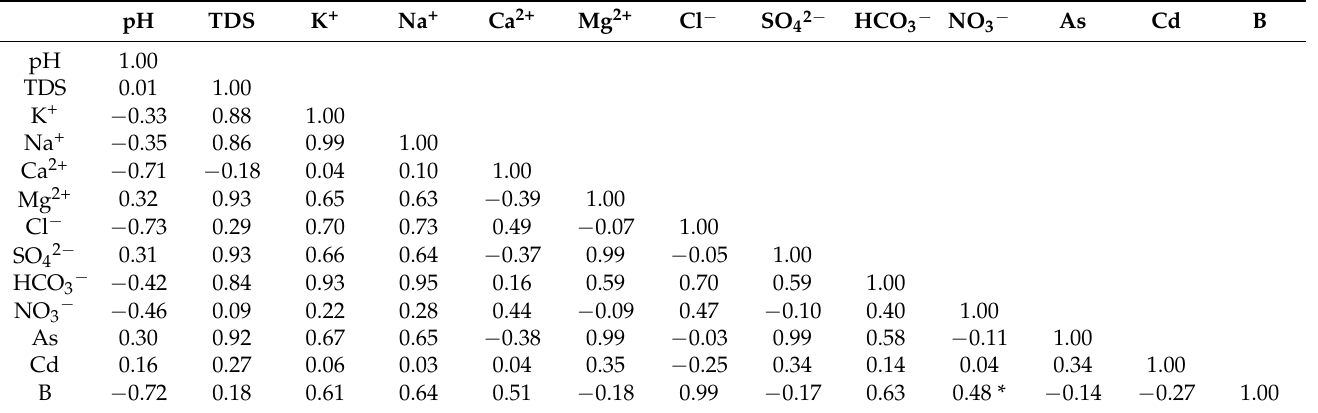
Table 3. Correlation coefficients of components for the collected sample.